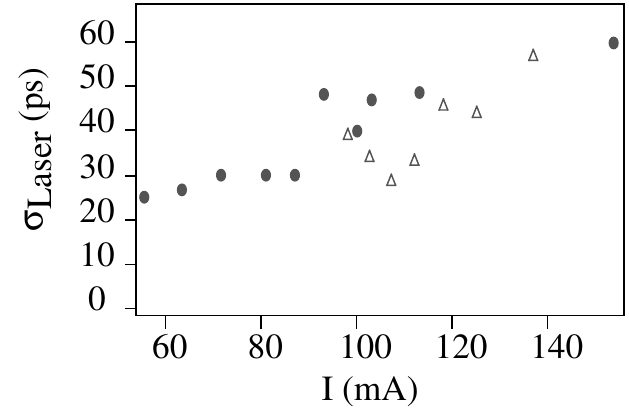
FIG. 12. FEL pulse duration in achromatic ( (cid:2) ) and chromatic ( 4 ) cases. The rms value of this distribution was calculated via the momenta method.